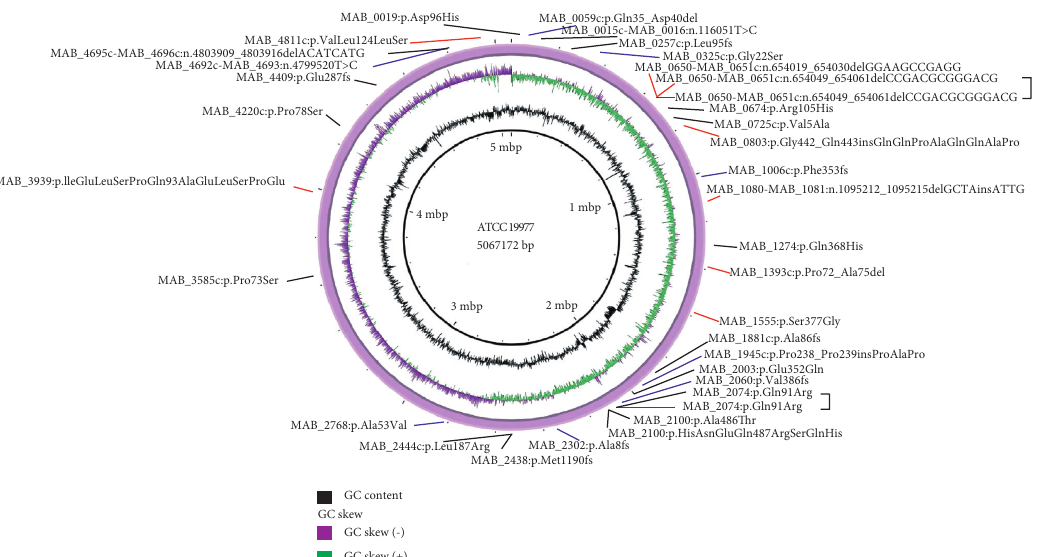
Figure 3: Mutation profiles of clarithromycin-acquired resistant M. abscessus. We showed mutations present in 3 clarithromycin-acquired resistant M. abscessus strains compared to the initially clarithromycin-susceptible strains. Variants in red indicate that the variants exist in G179 compared with G142; variants in black indicate that the variants exist in A243 compared with A38; variants in blue indicate that the variants exist in A137 compared with G139. ATCC 19977 served as the reference genome.